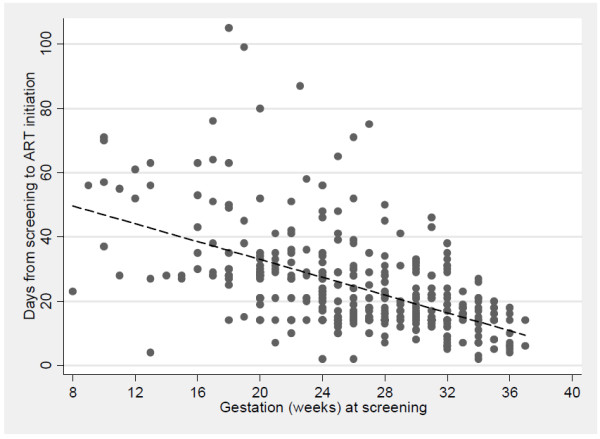
Plot of gestation at first screening visit in ART clinic (x-axis) and delay between screening and ART initiation before delivery (y-axis), among 382 pregnant women initiating ART. Points are individual observations, with best-fit line summarizing the overall association.